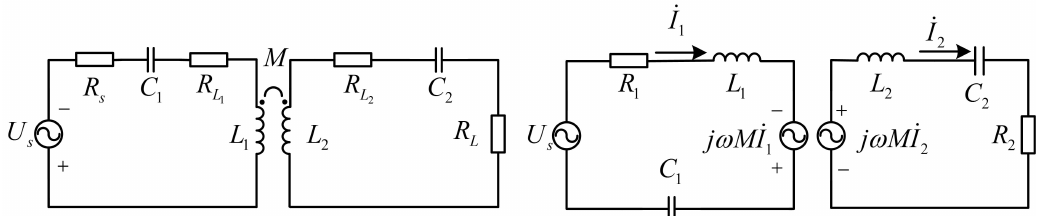
Figure 1. Equivalent circuit of the Series-Series (S-S) topology Magnetic Resonance Coupling Wireless Power Transfer (MRC-WPT)